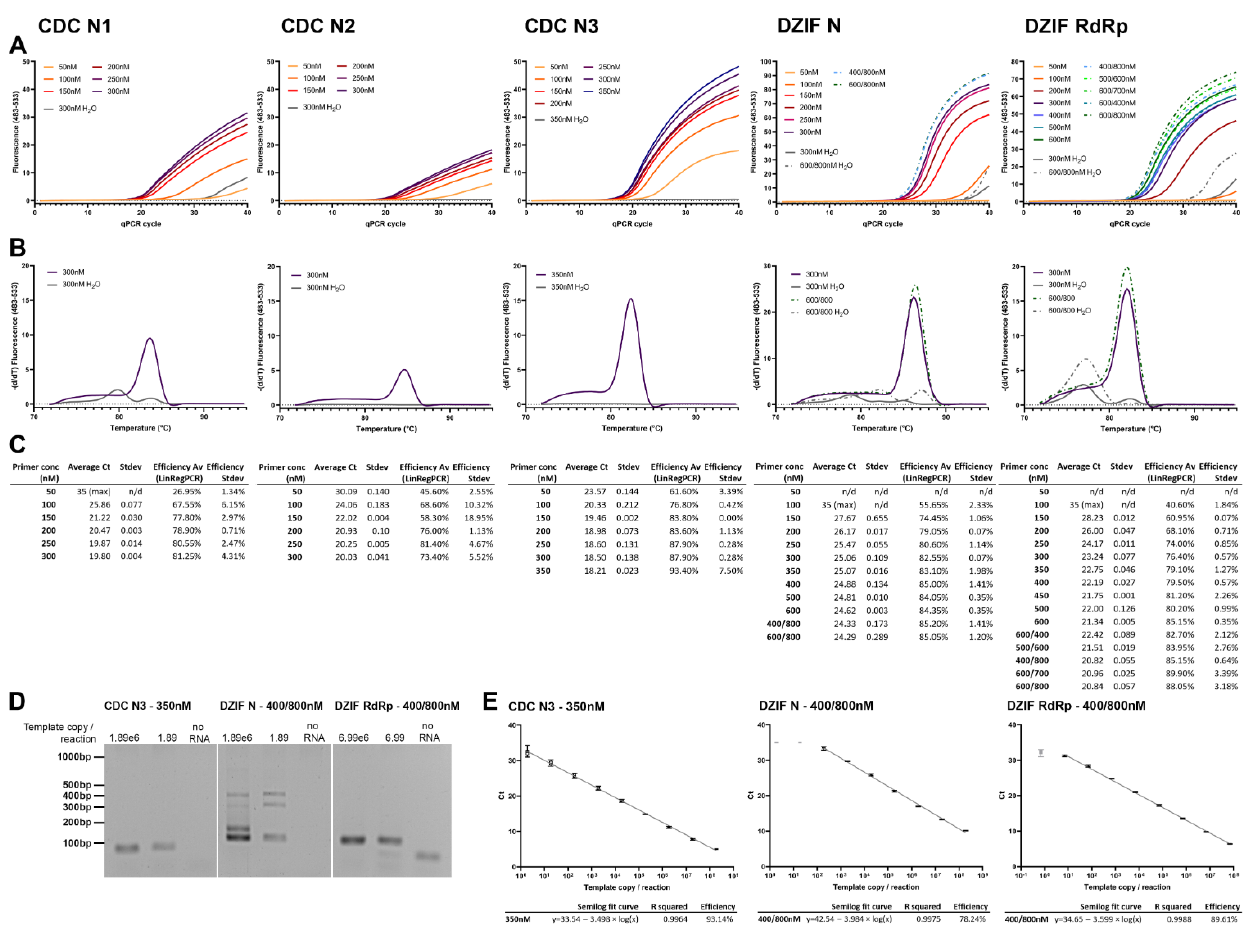
Figure 1. Primer selection for 1-step RT-qPCR amplification of SARS-CoV-2. Increasing symmetric (single number) and asymmetric (forward/reverse separated) concentrations of forward and reverse primer pairs were tested in a 1-step RT-qPCR reaction using templates representing the respective target regions. Primer sets CDC N1, N2, and N3, and DZIF N and RdRp (from left to right) were tested using 699 (CDC N2 and DZIF RdRp) or 1890 (CDC N1 and N3, and DZIF N) template copies per reaction. ( A ) shows the amplification curves of selected primer concentrations. Exact concentrations for each curve are listed in the legend for each graph. Continuous lines represent symmetric concentrations whilst dash/dot curves show asymmetric primer concentrations. Grey curves depict no template reactions. ( B ) shows the melting curves (72 – 95 °C) of the PCR reaction with the highest shown symmetric, and if shown in ( A ), asymmetric concentration. ( C ) shows the Ct values as calculated using the LightCycler software using the 2nd derivative of the max calculation. Efficiencies for each amplification were calculated using LinRegPCR. n = 2; curves represent the average. ( D ) PCR products obtained were analyzed on an agarose gel to assess primer – dimer formation in high and low template (indicated above gel pictures) RT-qPCR reactions. ( E ) Serial dilutions of template were run in RT-qPCR reactions to assess efficiency of the PCR reactions for the best performing primer pairs. A semilog fit curve was calculated using GraphPad prism to assess reaction efficiency from the slope. Samples excluded from the efficiency calculation are greyed out, as they were beyond reaction sensitivity limits. n = 3 × 2, error bars represent min and max.